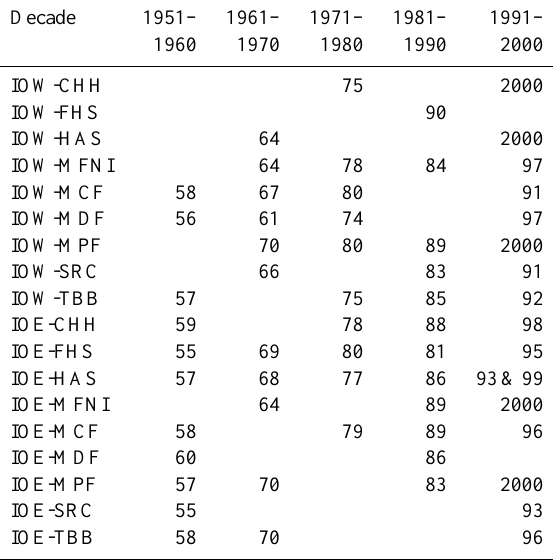
Table A2b. (b) Indicates the fish species over the Indian Ocean.